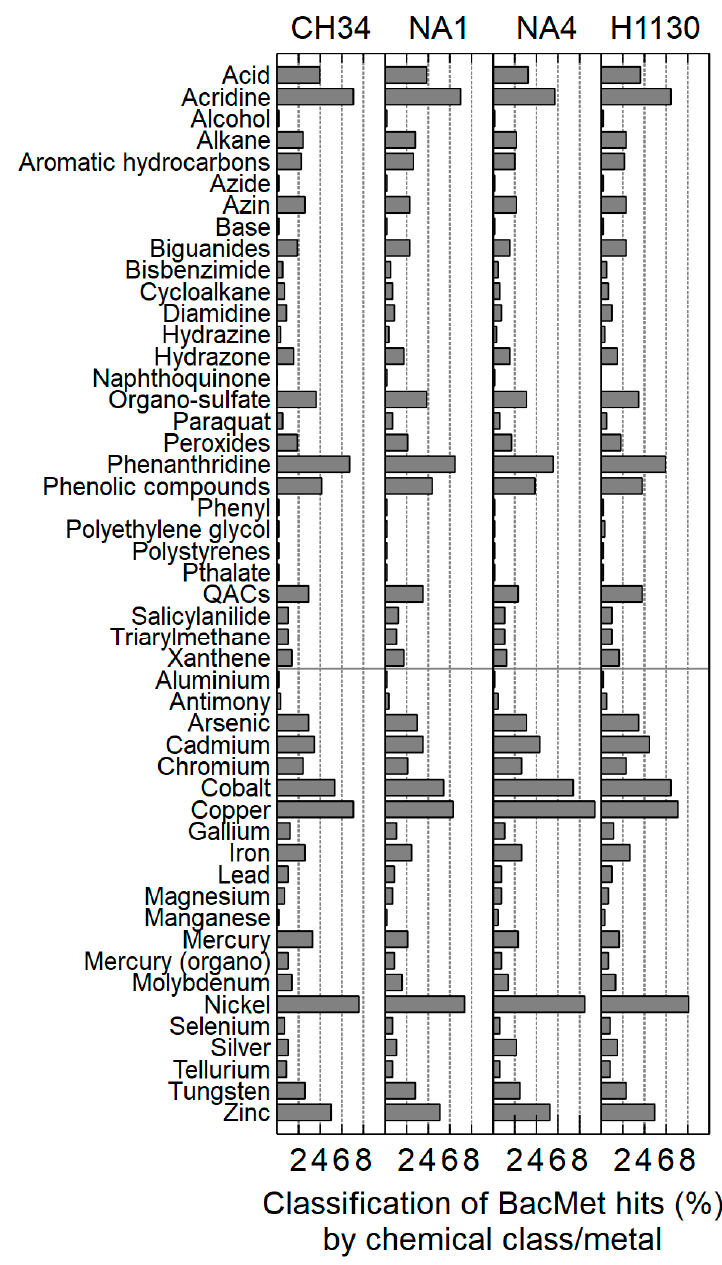
Figure 7. Inventory of C. metallidurans CH34, NA1, NA4 and H1130 genes conferring resistance